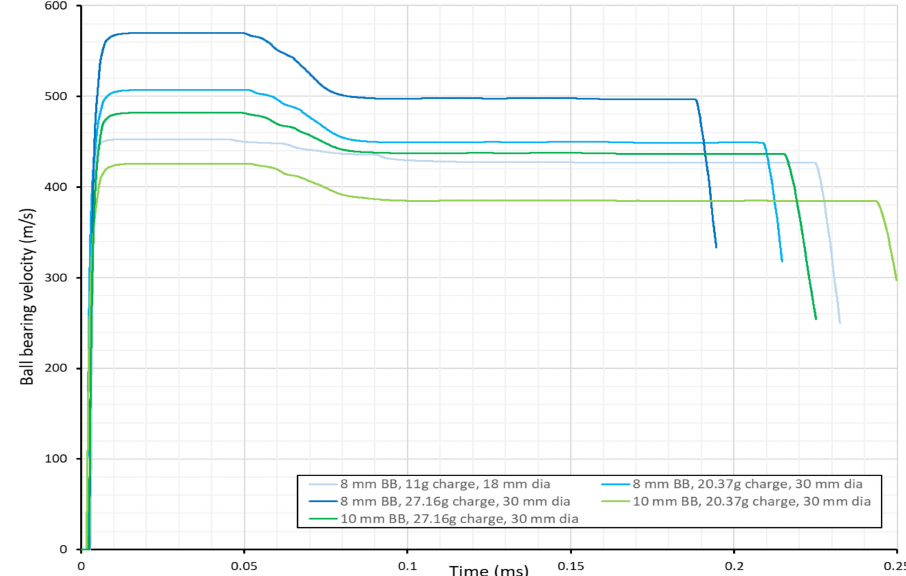
Figure 9. Simulated ball bearing velocity–time histories for 8 mm and 10 mm diameter ball bearings at different charge